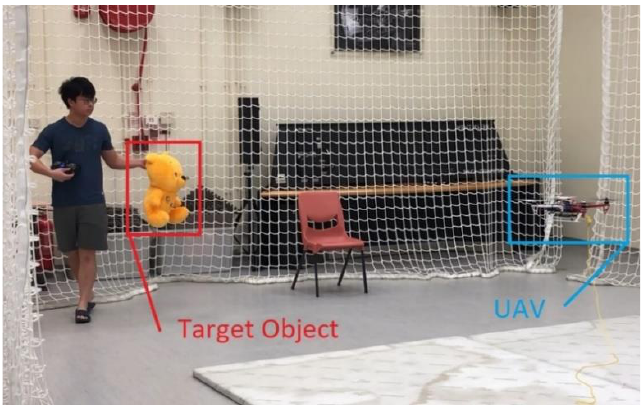
Figure 7. Flight test under the motion capture arena.